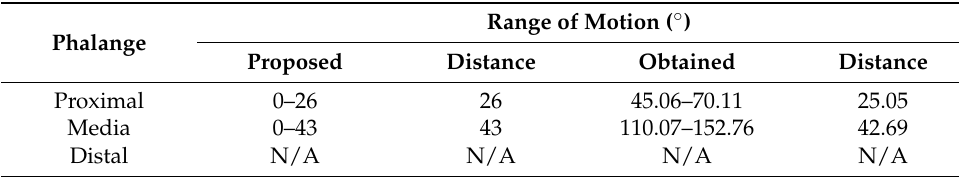
Table 3. Range from position analysis vs. range proposed.